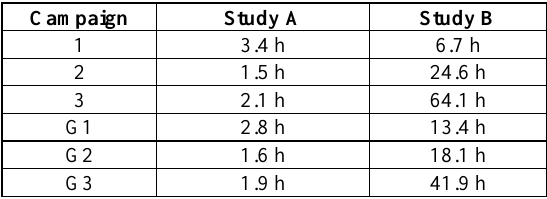
Table 8 . Campaign